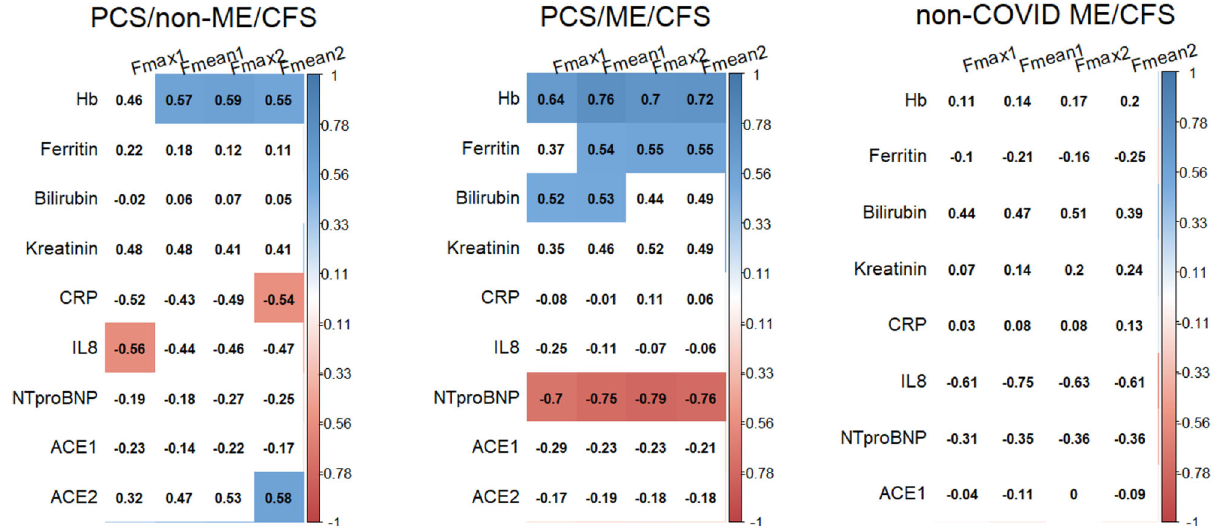
Fig. 5 | Correlation of hand grip strength (HGS) with laboratory parameter. PCS/non-ME/CFS post-COVID-19 syndrome/non-myalgic encephalomyelitis/ chronic fatigue syndrome; PCS/ME/CFS post-COVID-19 syndrome/myalgic ence- phalomyelitis/chronic fatigue syndrome; non-COVID ME/CFS non-COVID-19 myal- gic encephalomyelitis/chronic fatigue syndrome; Hb hemoglobin; CRP C-reactive protein; IL8 interleukin 8; NT-proBNP N-terminal prohormone brain natriuretic